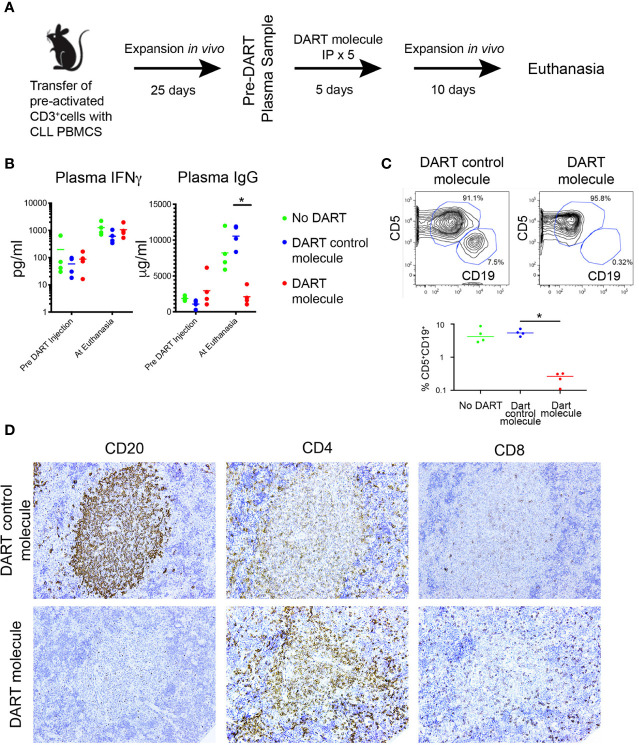
The PBMC + aT PDX model demonstrates the activity of a CD19xTcR-specific DART. (A) Mice (n = 15) were injected with 0.5 × 106 anti-CD3/28 + IL-2 pre-activated CLL-derived T cells and 20 × 106 CLL PBMCs on Day 0. Expansion of both T and B cells was determined 25 days post transfer by detection of human IFNγ, and human IgG in murine plasma samples. DART bispecific antibodies (DART molecule, n = 4 animals; or DART control molecule, n = 4 animals) or saline were administered ip from Day 30 to Day 34. Plasma levels of human IFNγ and IgG were further determined at day 46 when euthanasia was performed. Animals with <10 pg/ml IFNγ at Day 25 were excluded from receiving DARTs and were not included in the analysis making 3 groups of 4 animals for each condition. (B) Plasma levels of IFNγ and IgG in the 3 groups of animals (n = 12, 4 per group), taken pre-DART injection at Day 25 and at euthanasia at Day 40. Results show no significant differences in IFNγ levels between the 3 groups before DART molecule injection and at euthanasia. In contrast, plasma Ig levels are significantly lower in CD19xTcR DART-treated animals (red dots), compared to the DART control molecule-treated control animals (blue dots). * corresponds to Kruskal-Wallis test P value < 0.05. (C) FC reveals absence of CD5+CD19+ cells in DART molecule-treated animals. Illustrative FC plots are representative of hCD45 single cell splenic suspensions obtained at euthanasia. Graph shows median CD5+CD19+ cells in each group as a percentage of total hCD45+ cells isolated. Compared to DART control molecule-treated control animals (blue dots), there are significantly fewer CD5+CD19+ cells in DART molecule-treated animals (red dots). * corresponds to Kruskal-Wallis test P value < 0.05. (D) Representative IHC (x20 original magnification) of DART control molecule-treated animals (upper panel) compared to DART molecule-treated animals (lower panel). These results were apparent for both a U-CLL1539 (illustrated in Figure) and M-CLL0545.